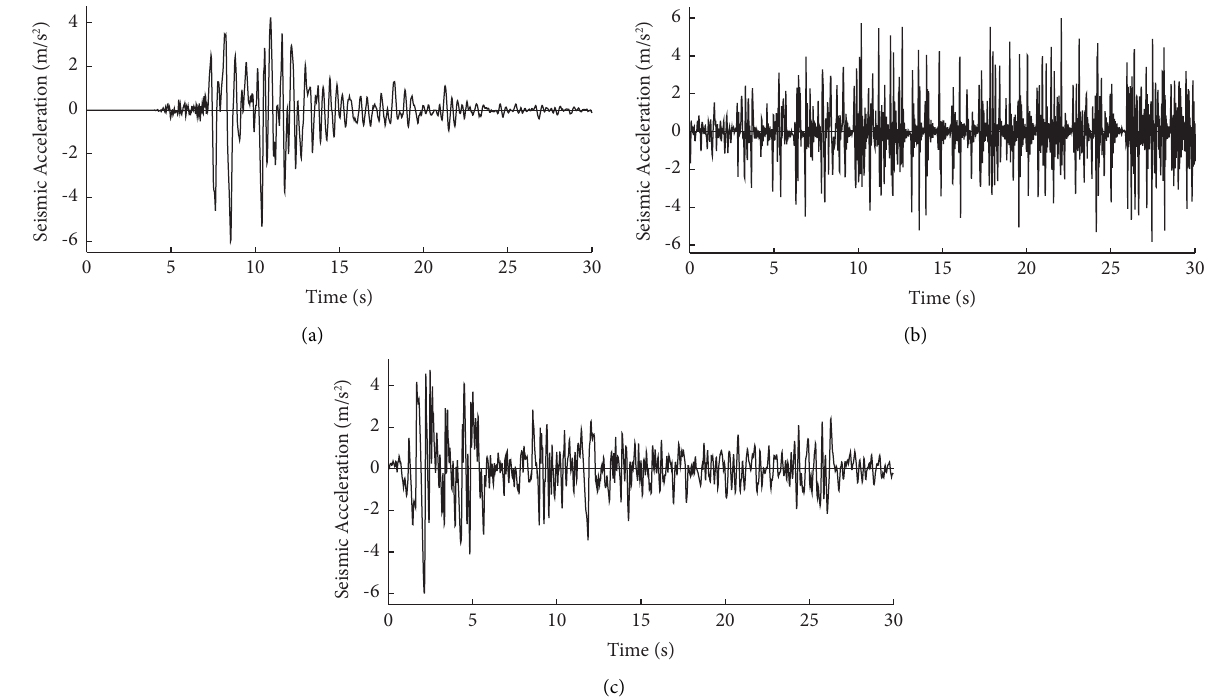
Figure 4: Tree waveforms loaded on the shaking table (0.6g). (a) Kobe wave. (b) Wenchuan wave. (c) EL Centro wave. -9-6-3036